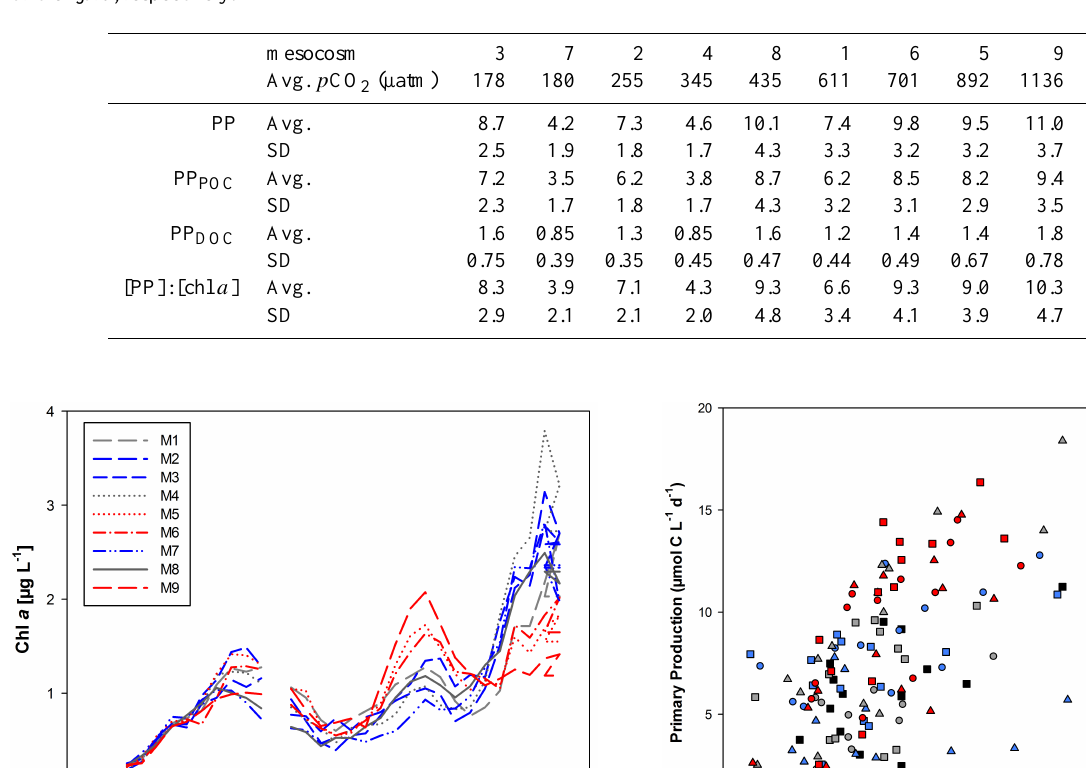
Table 1. Time averaged (day 5–day 28) rates (µmolCL − 1 d − 1 ) of total primary production (PP), primary POC production (PP POC ), and primary DOC production (PP DOC ), based on 14 C bottle incubations, as well as ratios of PP normalized to chlorophyll a concentration (µmolCµg − 1 chl a d − 1 ). Averages (Avg.) and standard deviations (SD) were calculated from n = 12 observations for each mesocosm and for the fjord, respectively.